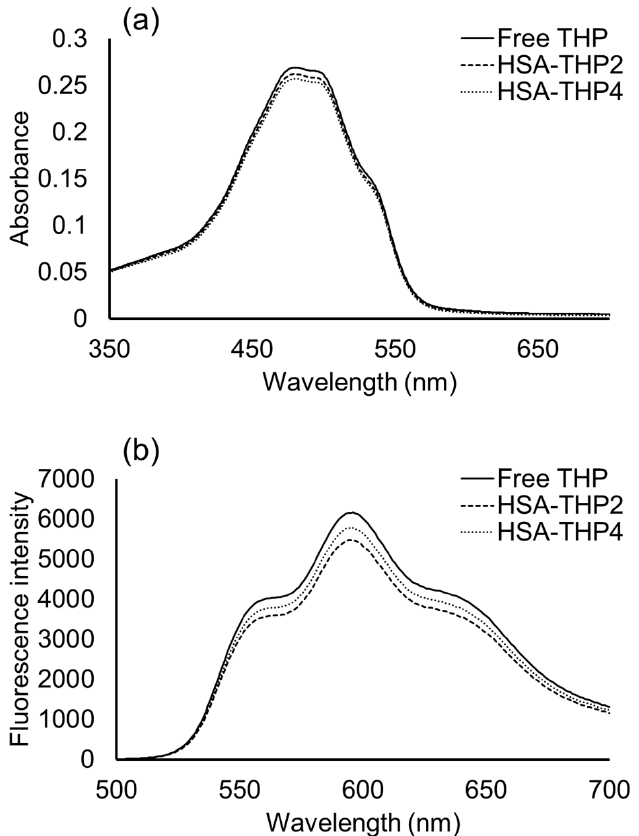
Figure 5. ( a ) UV/VIS spectra and ( b ) fluorescence spectra of HSA-THP2 and HSA-THP4 in 0.01 M phosphate and 0.15 M NaCl (pH 7.4).